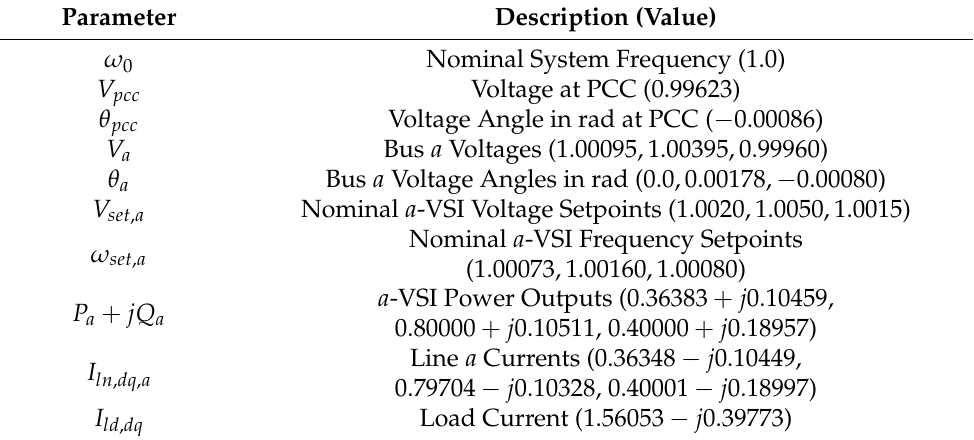
Table 2. Steady-State Initial Operating